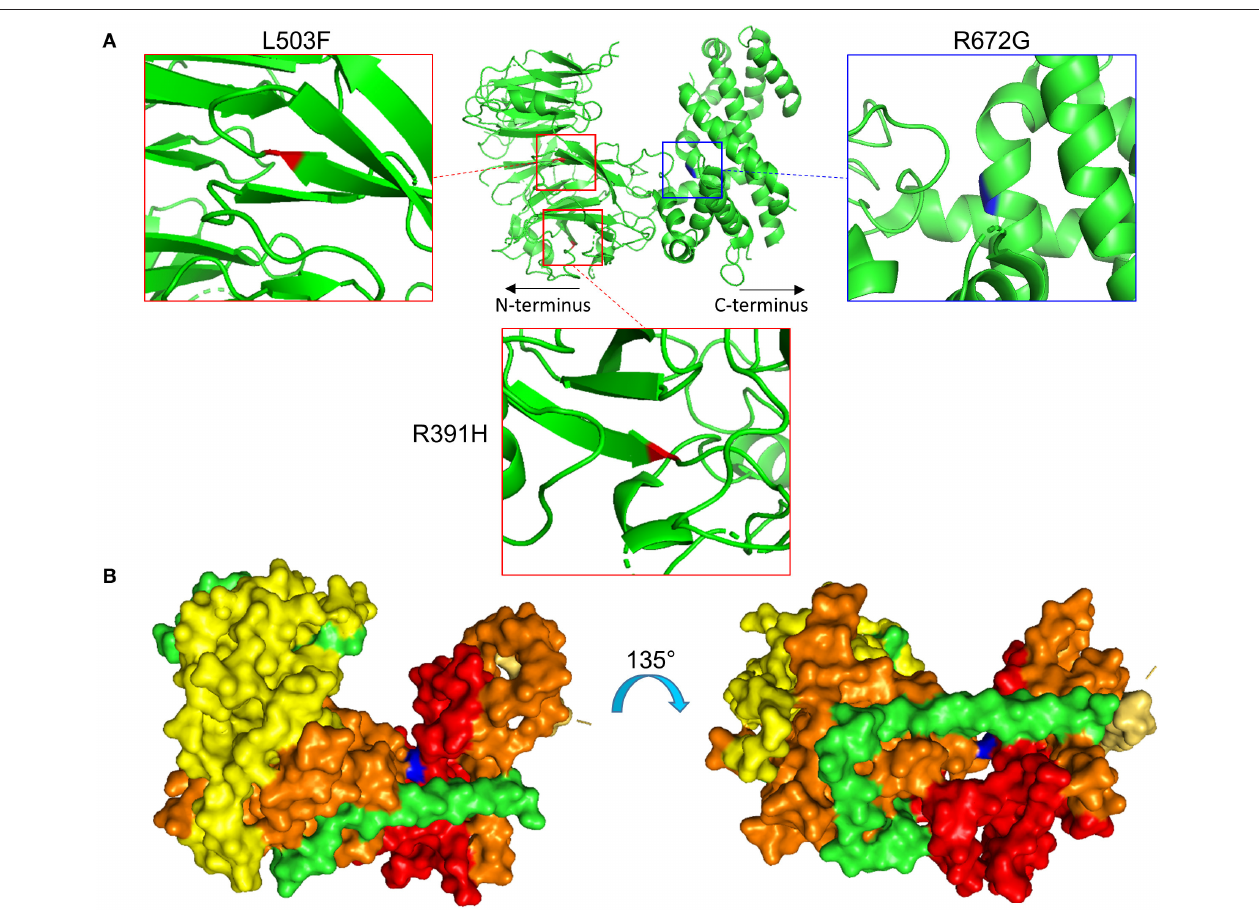
FIGURE 4 | Location of specific NUP155 variants. (A) Predicted 3-dimensional structural distribution of potential pathogenic amino acid substitutions reveal that two clinically associated mutations, R391H and L503F (see text), are found embedded within the beta-propeller feature of NUP155. Our highest prioritized NUP155 variant, R672G, is found within the alpha-helical region of the crescent shaped domain. Shown is the crescent shaped region, with the two clinical variants highlighted in red and the highest prioritized variant highlighted in blue. Boxes provide magnified views of all three variants. (B) Surface rendering of the crescent shaped region of NUP155 reveals central location of the R672G residue (blue) from front and back “sides” of the